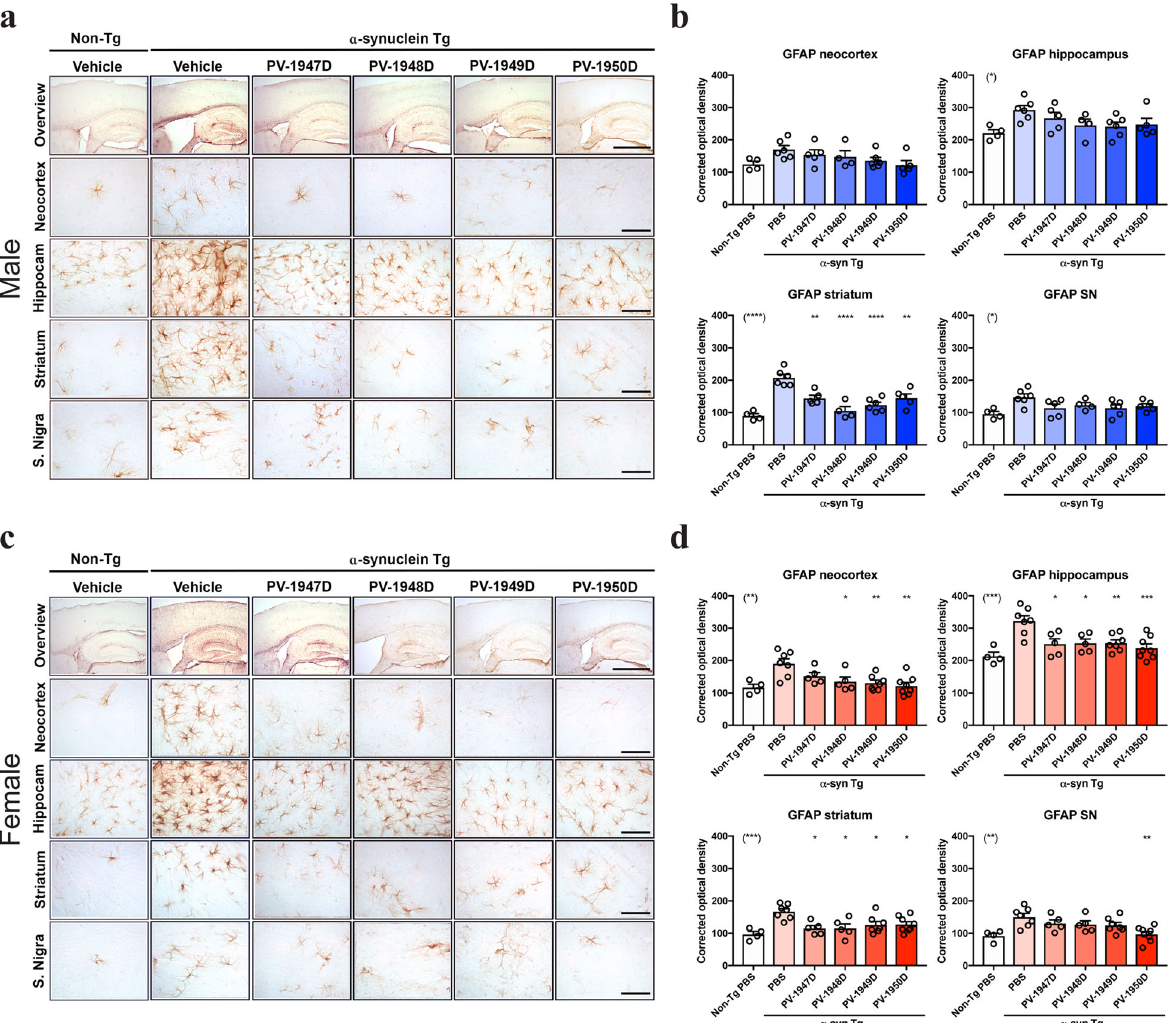
Fig. 7 Vaccination with MultiTEP-based DNA vaccines signi fi cantly reduced astrogliosis in α -synuclein transgenic mice. a Representative images of brain sections from male mice immunostained with an antibody against the astroglial marker-GFAP. Each panel illustrates from top to bottom an overview of the brain, neocortex, hippocampus, striatum, and substantia nigra regions in non-Tg, and α Syn Tg mice with a vehicle, PV-1947D, PV-1948D, PV-1949D, and PV-1950D vaccination. b Image analysis of GFAP immunoreactivity expressed as corrected optical density in the neocortex, hippocampus, striatum, and substantia nigra of male mice. c Representative images of the brain sections of female mice immunostained with an antibody against the astroglial marker-GFAP. Each panel illustrates from top to bottom an overview of the brain, neocortex, hippocampus, striatum, and substantia nigra regions in non-Tg, and α Syn Tg mice with a vehicle, PV-1947D, PV-1948D, PV-1949D, and PV-1950D vaccination. d Image analysis of GFAP immunostaining expressed ad corrected optical density in the neocortex,